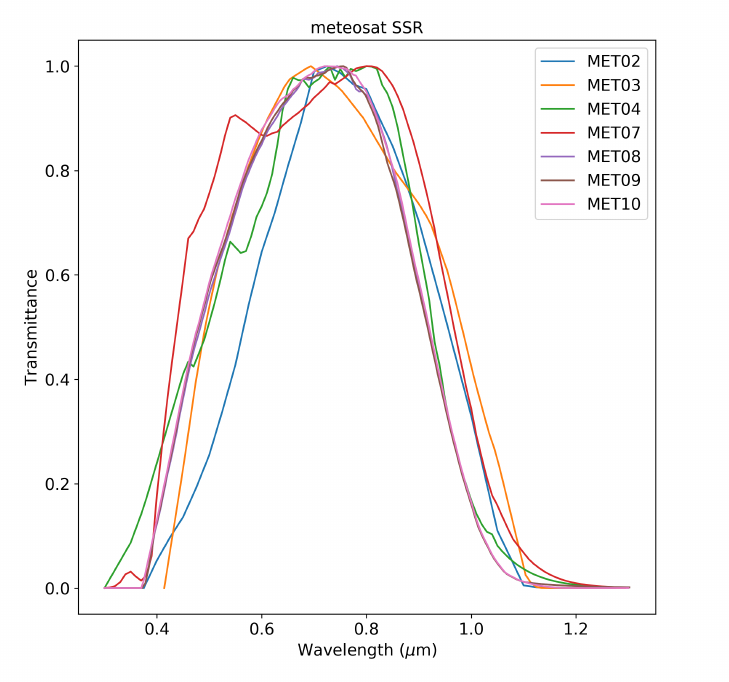
Figure 1. Meteosat Sensor Spectral Response (SSR) for the VIS (HRV) band of MVIRI/MET02 to MET07 (SEVIRI/MET08 to